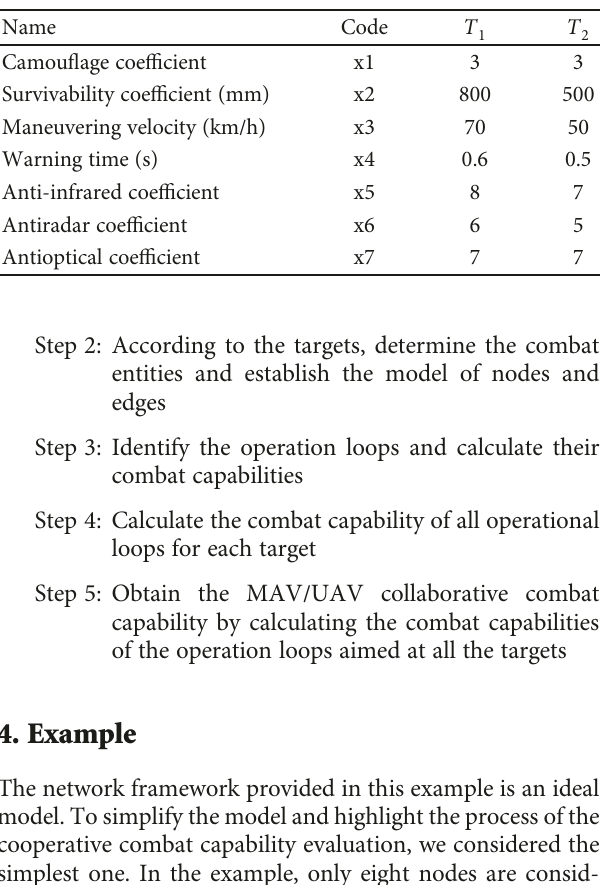
Table 1: Tactical indexes of T